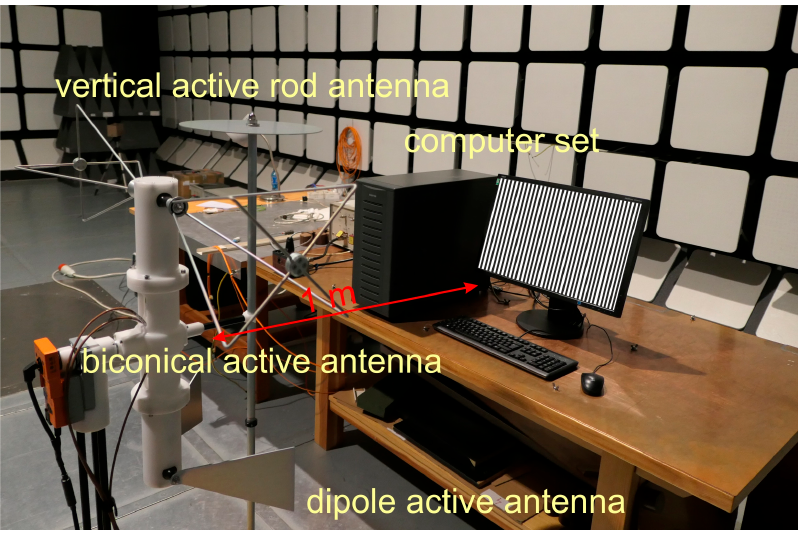
Figure 8. The measuring system of revealing emission signals. Initial (rough) line length estimation was performed in the Program Raster Generator for the given catalog operating parameters of the test computer monitor (for known param- eters). If such parameters are not known-no access to the eavesdropped monitor or for the displays of multifunction devices-their rough estimation can be performed in accordance with the algorithm of the Chirp-Z transform or periodicity analysis of the recorded emis- sion signal of revealing [34,35,52,53]. As previously mentioned, this is the step of roughly determining the line length of the reconstructed image. In the first stage, the line length estimation is performed with accuracy to unity in the vicinity of ± 10 around the roughly determined d value of the line length. This means that for d 1 = 1087, the estimation of the value of d ∆ is carried out in the range from 1077 to 1097, in which the maximum (minimum) of the adopted measure may correspond to the value of 1089. Similarly, if the accuracy is increased to 0.1, the estimation is carried out in the range from 1088.0 to 1090.0 in steps of 0.1. Then, for the determined length d ∆ with an accuracy of 0.1 (e.g., 1088.4), the estimation accuracy is increased to 0.01. Calculations are performed in the range from 1088.30 to 1088.50. Details of the line length estimation of the reconstructed image with an accuracy of up to 0.00001 are described in the form of the algorithm shown in Figure